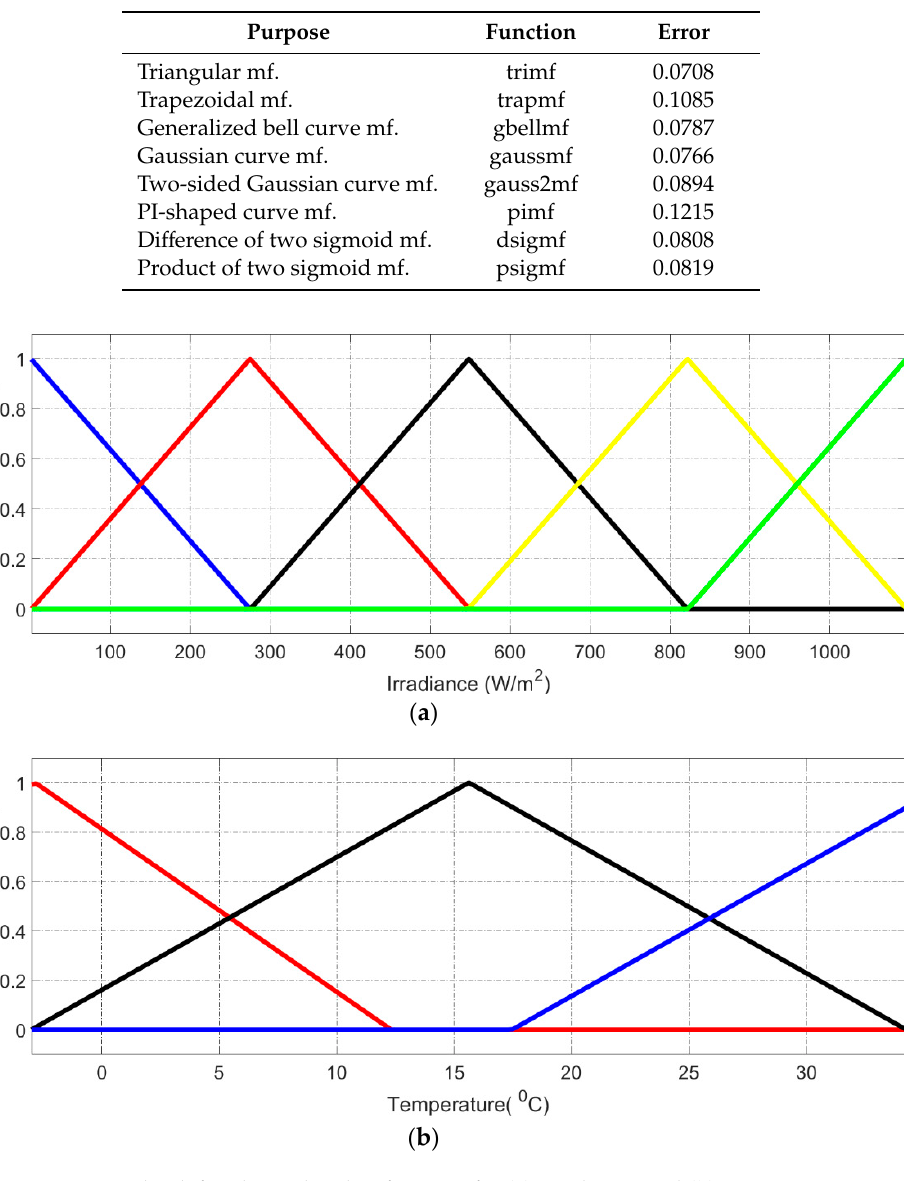
Figure 8. The defined membership function for ( a ) irradiance and ( b ) temperature.